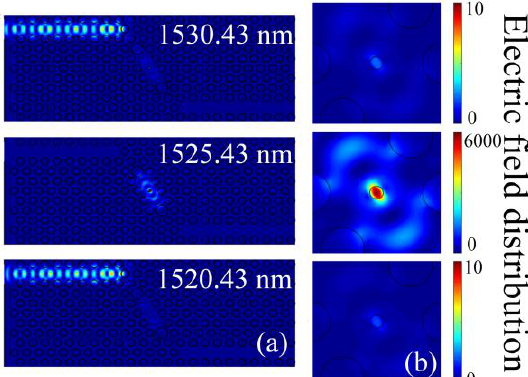
Figure 3. Steady-state electric field distribution for incident wavelengths of 1530.43, 1525.43 and 1520.43 nm. ( b ) is the cavity area corresponding to ( a ).